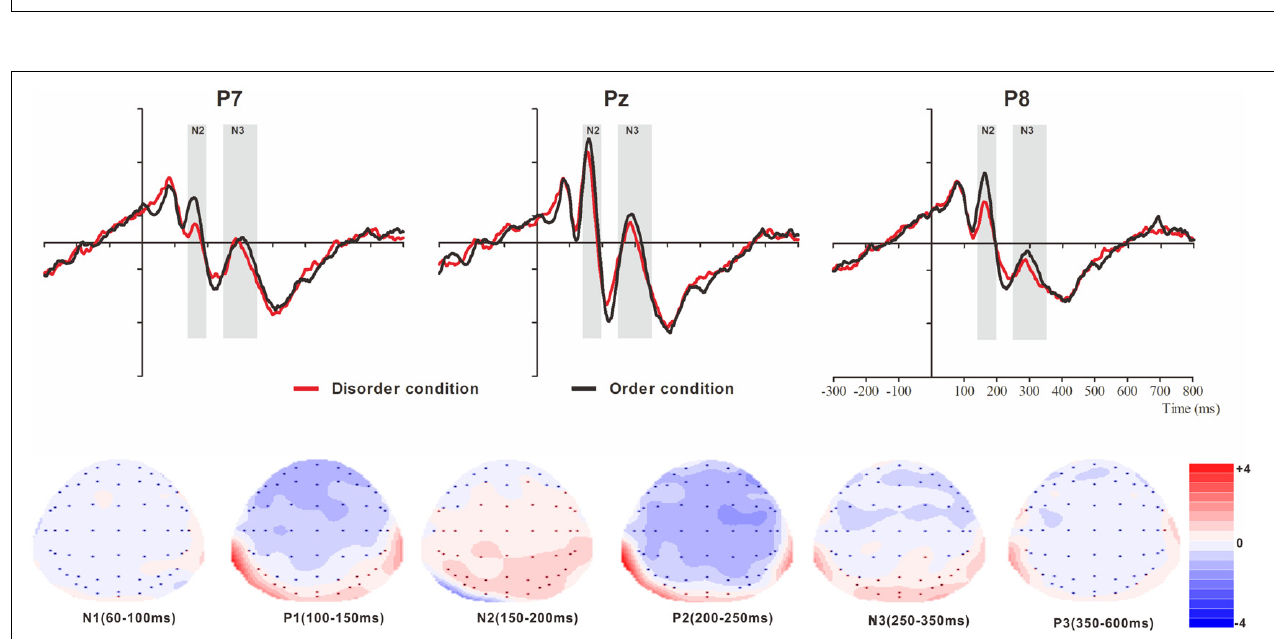
FIGURE 2 | Top: Average ERP waveforms at frontal F7, Fz, and F8 electrodes elicited by centrally presented basic visual disorder (red line) or order (black line) pictures. The significant differences between the disorder and order conditions are indicated by the gray (negative differences) and earthy yellow (positive differences) rectangles, respectively. Time = 0 ms indicates the stimulus onset. Bottom: Topographic maps of the mean voltage amplitudes for the difference waveforms (disorder condition minus order condition) matched to the time window of each component elicited by the stimuli (notably the frontal locations). Increased negativity is shown in blue, while increased positivity is shown in red.